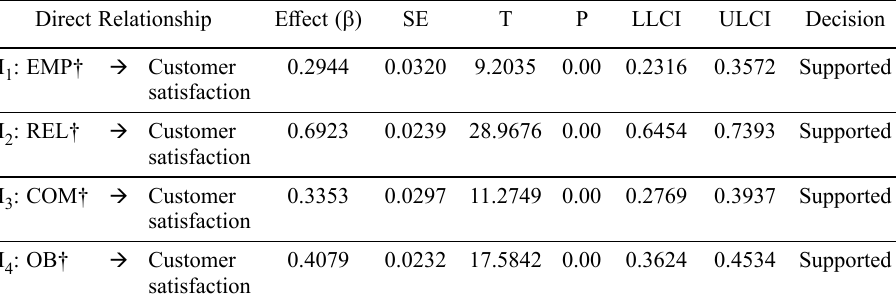
Table 6. Hypotheses testing summary for direct